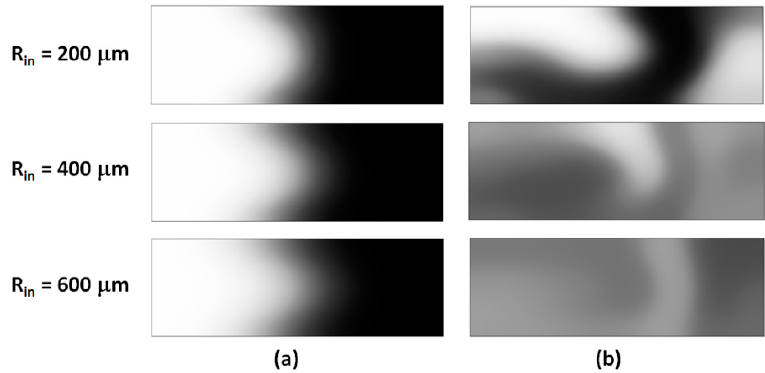
Figure 6. Transversal concentration distributions at the outlet of the mixing unit for ( a ) simple, and ( b ) grooved serpentines of different inner radius R in ( Re = 10).